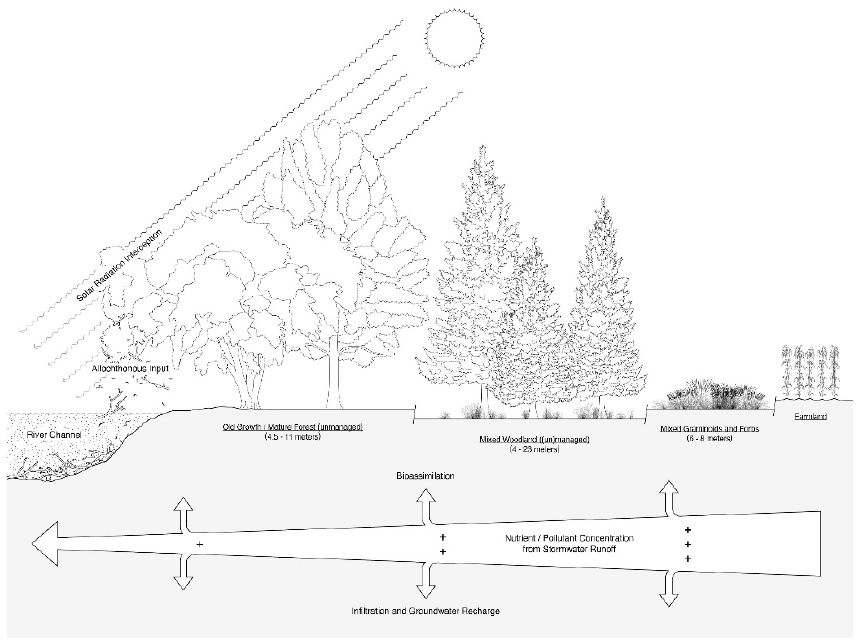
Figure 1. Ecological structure, functions, and multi-tiered delineation of riparian buffers.